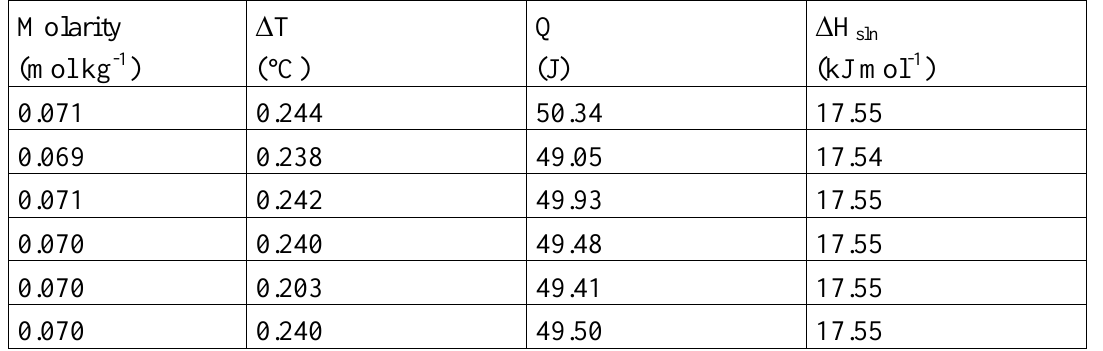
Table 3. Determination of the Enthalpy of Solution for KCl in Water at 25